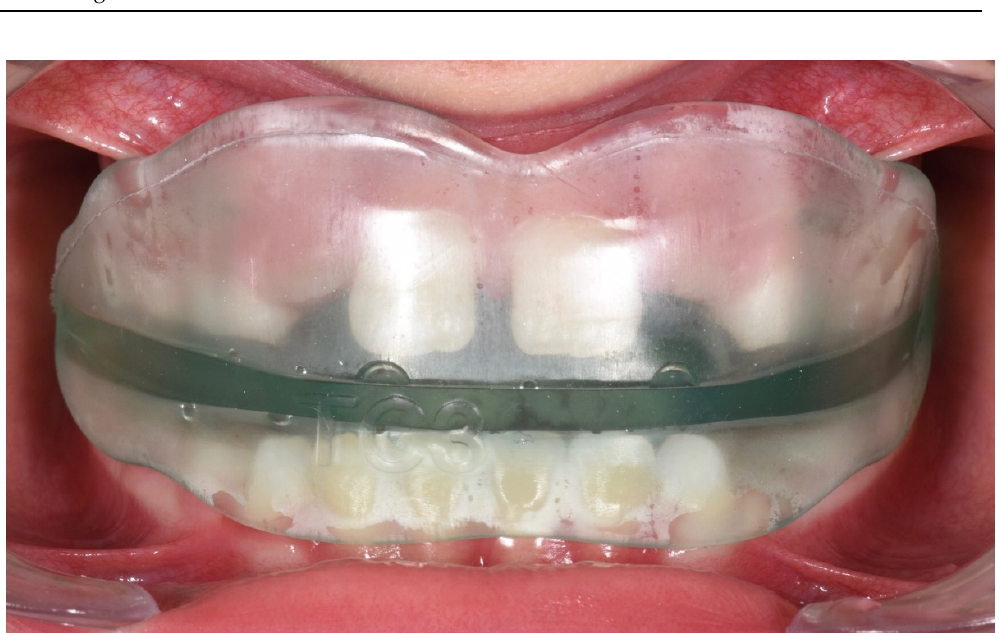
Figure 16. Intraoral photograph of the patient wearing the AMCOP TC.